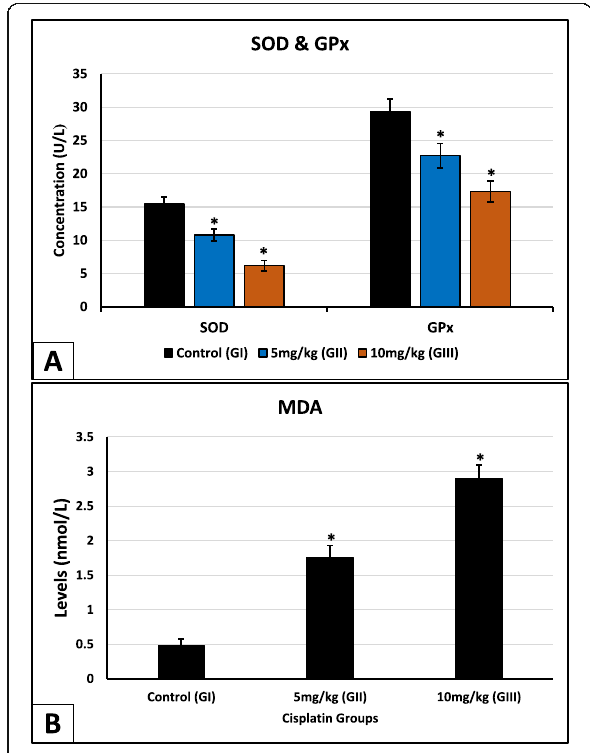
Fig. 1 a Activities of superoxide dismutase (SOD) and glutathione peroxidase (GPx). b Levels of lipid peroxidation and MDA in serum of mice intraperitoneally injected with 5 and 10 mg/kg bw cisplatin twice/week for 4 weeks. Data are expressed as mean ± SD. N = 10 mice. *Significant differences at values of P ≤ 0.05